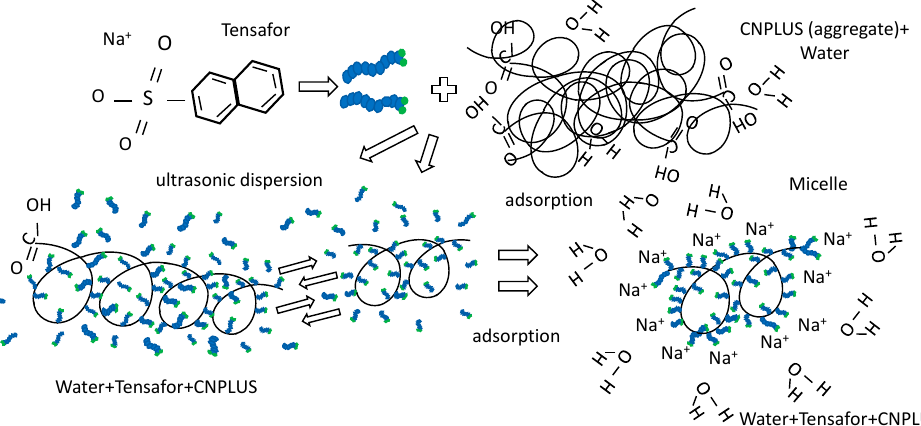
Figure 5. The process of adsorption and formation of a diffuse layer between the Tensafor molecules on the surface of CNPLUS.